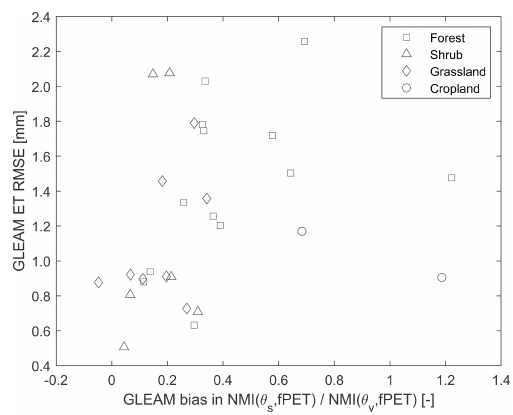
Figure 6. Daily ET error in GLEAM as a function of GLEAM bias in NMI( θ S , fPET) / NMI( θ v , fPET) ratio across 34 AmeriFlux sites.